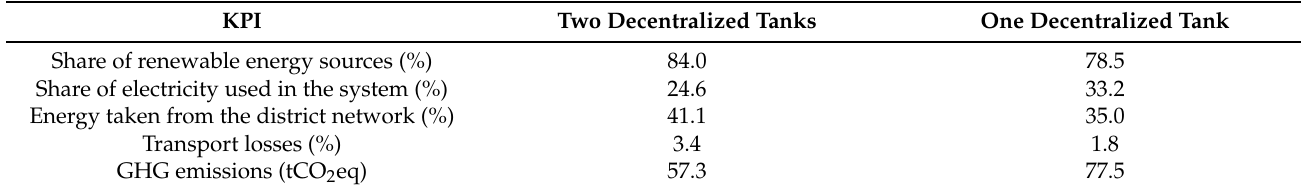
Table 6. KPI comparison between ENaQ retrofitted with one and two decentralized storage tanks. KPI Two Decentralized Tanks Share of renewable energy sources